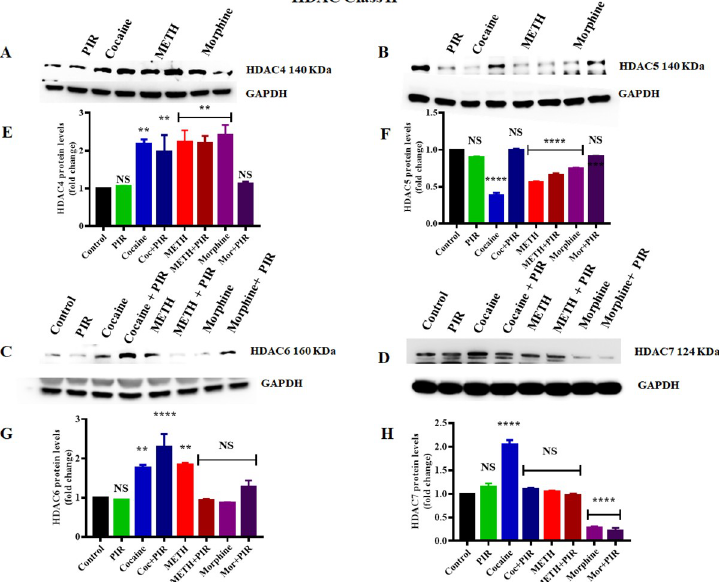
Fig 2. Effects of the psychostimulants cocaine, METH and morphine on HDAC class II proteins in human primary astrocytes. Cells were exposed to cocaine (1 μ M), METH (10 μ M), and morphine (5 μ M) either alone or in combination with piracetam (10 μ M) for 24 h. The protein expression levels of different classes of HDACs (4, 5, 6 and 7) in astrocytes were determined by western blotting analysis using GAPDH as a loading control. Western blot showing (A) HDAC4, (B) HDAC5, (C) HDAC6 and (D) HDAC7. Two-way ANOVA analysis performed to compare the groups between cocaine Vs cocaine + piracetam, METH Vs METH + piracetam and morphine Vs morphine + piracetam. The densitometric analysis results in E, F, G and H represent the protein levels (fold-change control) of HDAC4, HDAC5, HDAC6 and HDAC7, respectively. The data are expressed as the mean ± standard error mean of three independent experiments. N = 3. ���� P < 0.0001, ��� P < 0.001, �� P < 0.01, NS—nonsignificant.